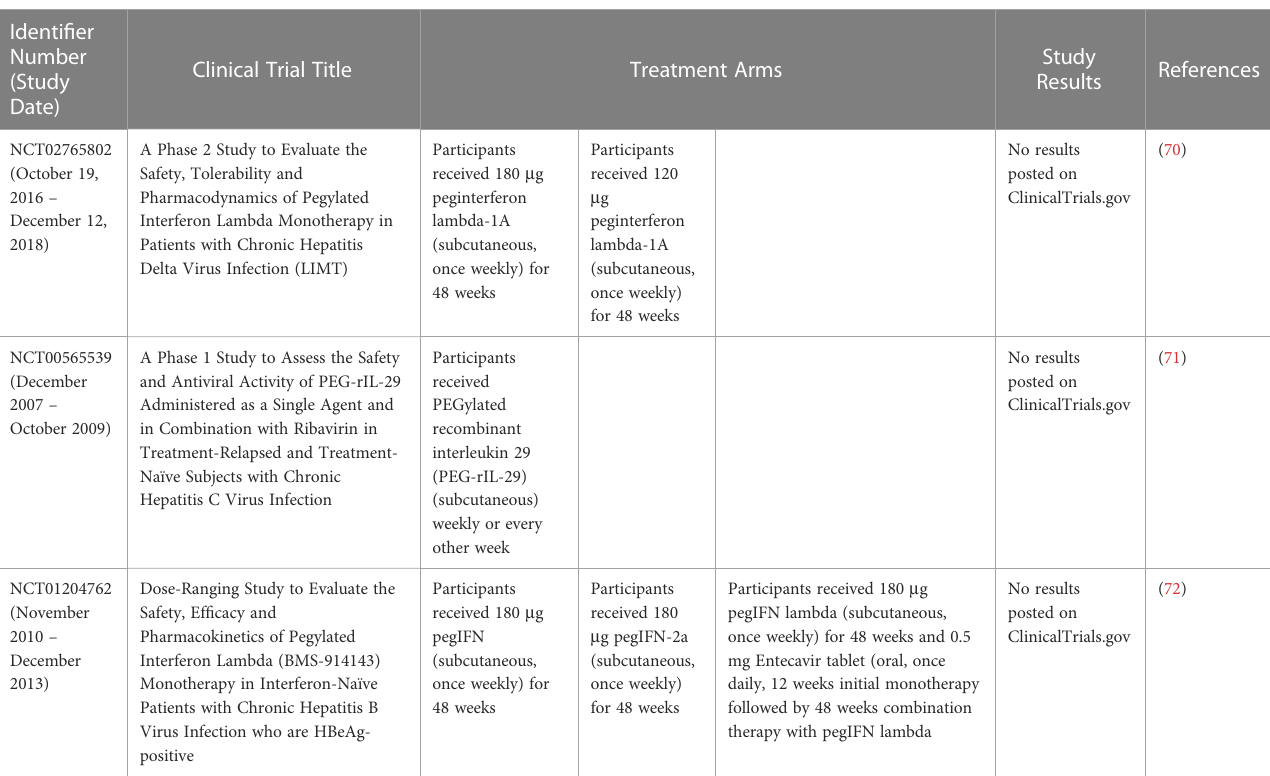
TABLE 4 Clinical trials of IFN- l and their